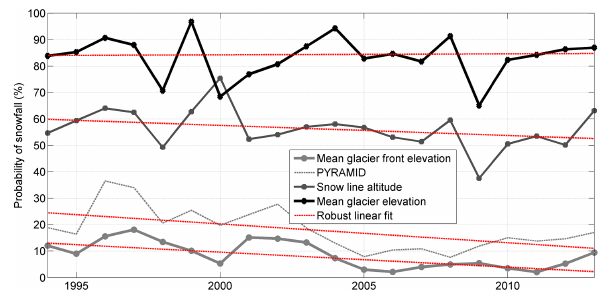
Figure 9. Trend analysis of annual probability of snowfall on total cumulated precipitation. The red lines represents the robust linear fitting of the time series characterized by the associated Sen’s slope (more details in the caption of Fig.